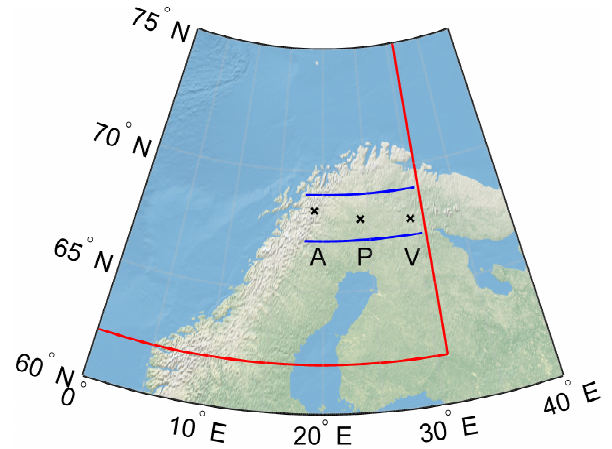
Fig. 1. A map of northern Scandinavia. The measurement stations are located approximately in a line from west to east in the fol- lowing order: Abisko, Pallas, Värriö (A, P, and V in the map). Red lines show the sector from where the trajectories are accepted when studied the aerosol dynamics over the continent. Blue lines show the limits for the trajectory paths when studying aerosol dynamics between the measurement stations (Map: Natural Earth